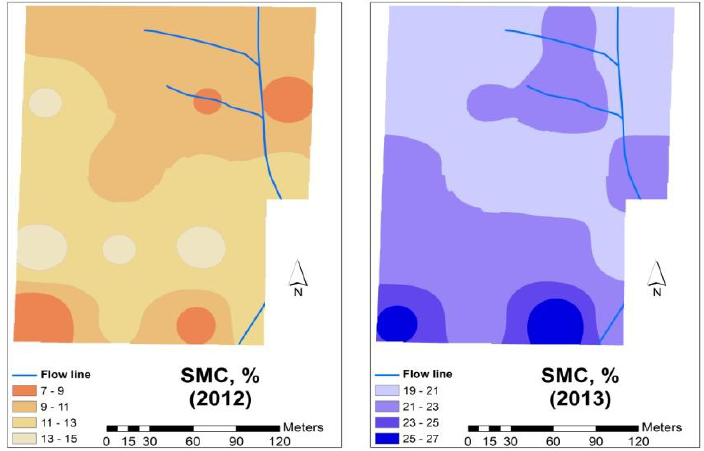
Figure 9. Spatial soil moisture variability in the experimental